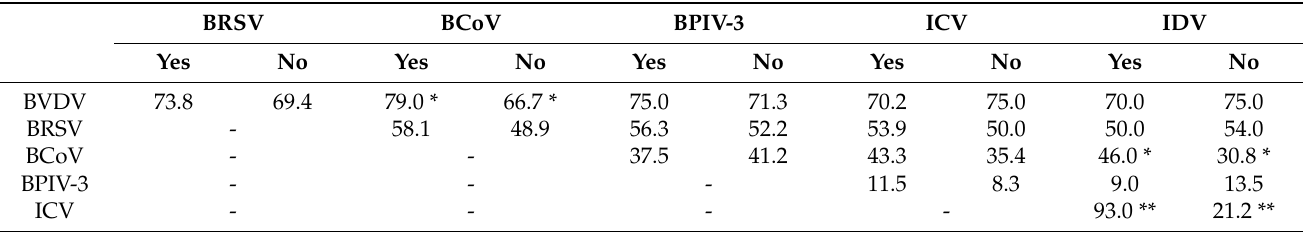
Table 3. Percentages of a virus (row) to infect together with (Yes) or without (No) another virus (column). * and ** indicate associations among both virus, row, and column, at p < 0.10 and 0.05, as a tendency and significant levels, respectively.